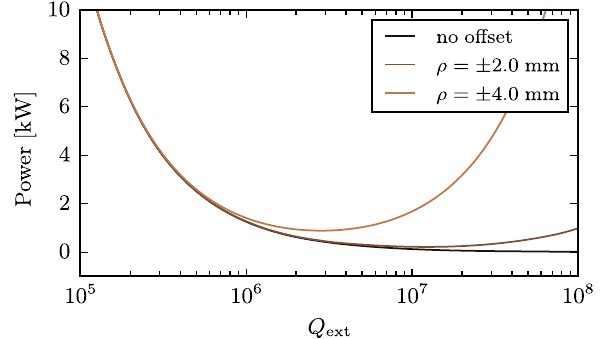
17. Input power as a function of the external quality factor ¼ 30 mm and a for a four-vane cavity with an iris radius of r ir ¼ 30 deg. The beam offset is represented tapering angle of α tap by the radial coordinate ρ . The bunch form factor F at 800 MHz b is around 0.5